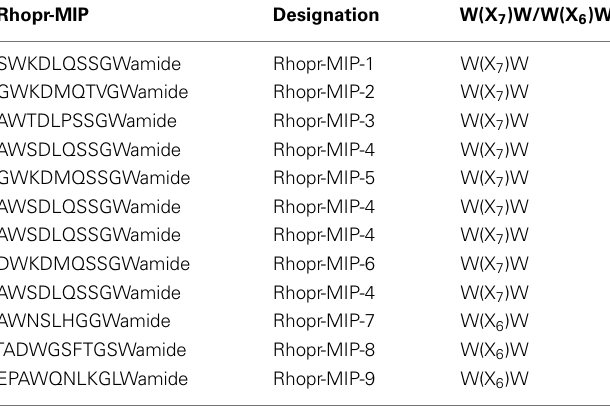
Table 1 | Rhodnius prolixus